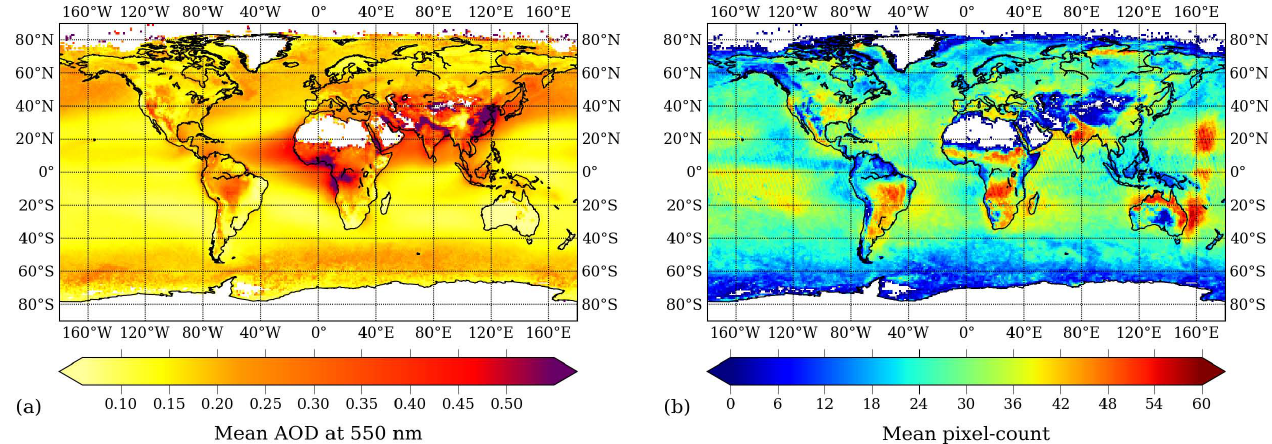
Fig. 1. (a) Mean AOD over the entire validation period; (b) mean pixel count. White areas are the regions without